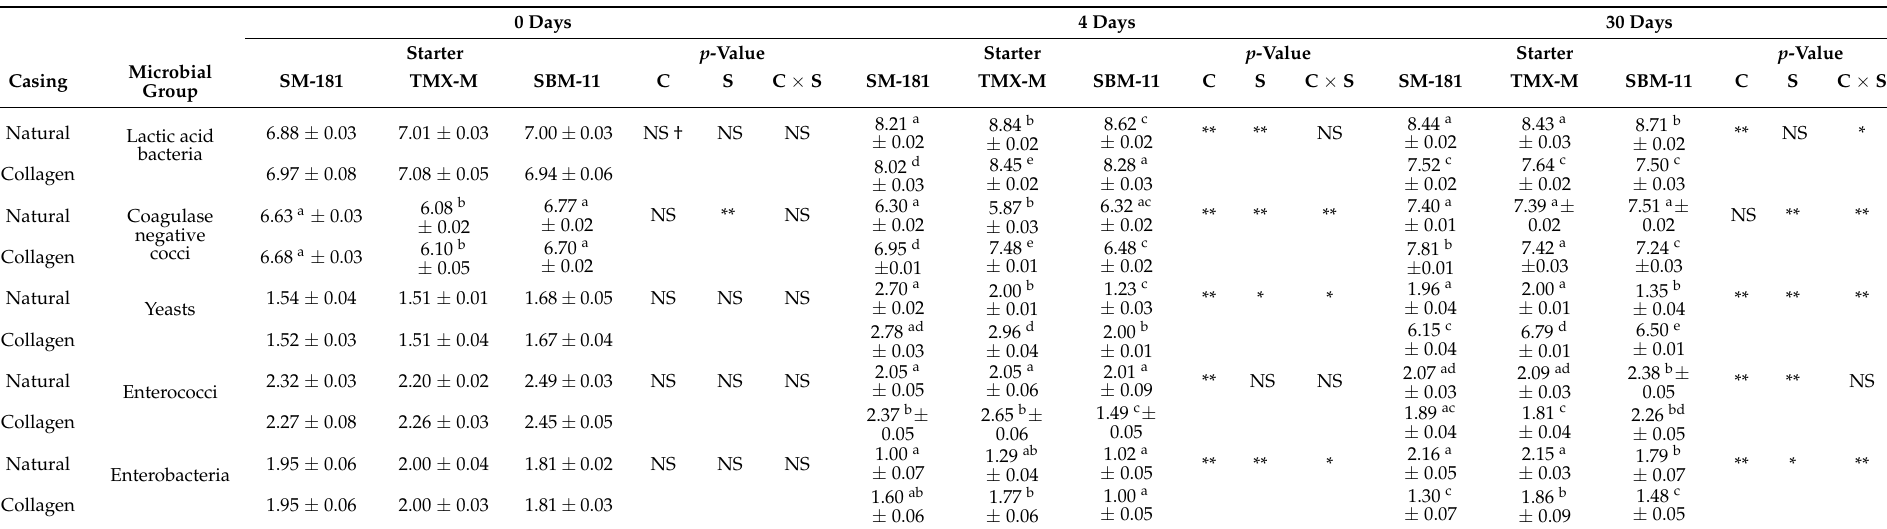
Table 1. Microbial counts (expressed as log CFU/g) on day 0, after 4 days and at the end of ripening (30 days) of fermented sausages obtained using three different starter cultures (SM-181, TMX-M and SBM-11) and stuffed into two different casings (natural and collagen). The data are the mean of three determinations in three independent samples (n = 9) and standard errors are reported. The results of a two-way ANOVA are also reported to evaluate the effects of the different experimental conditions and their interactions on counts. Differences were considered significant at p ≤ 0.05. 0 Days 4